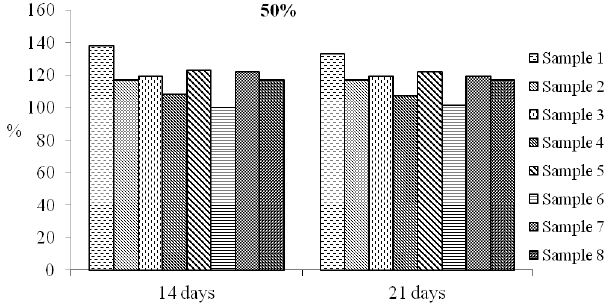
Figure 5. Comparison of the germination capacity of soil samples at a concentration of 50%.